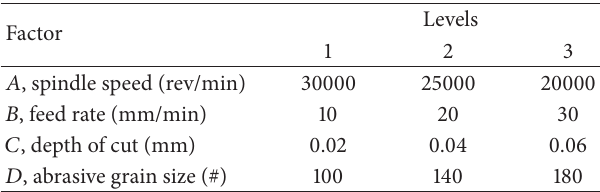
Table 1: Experimental levels and factors.